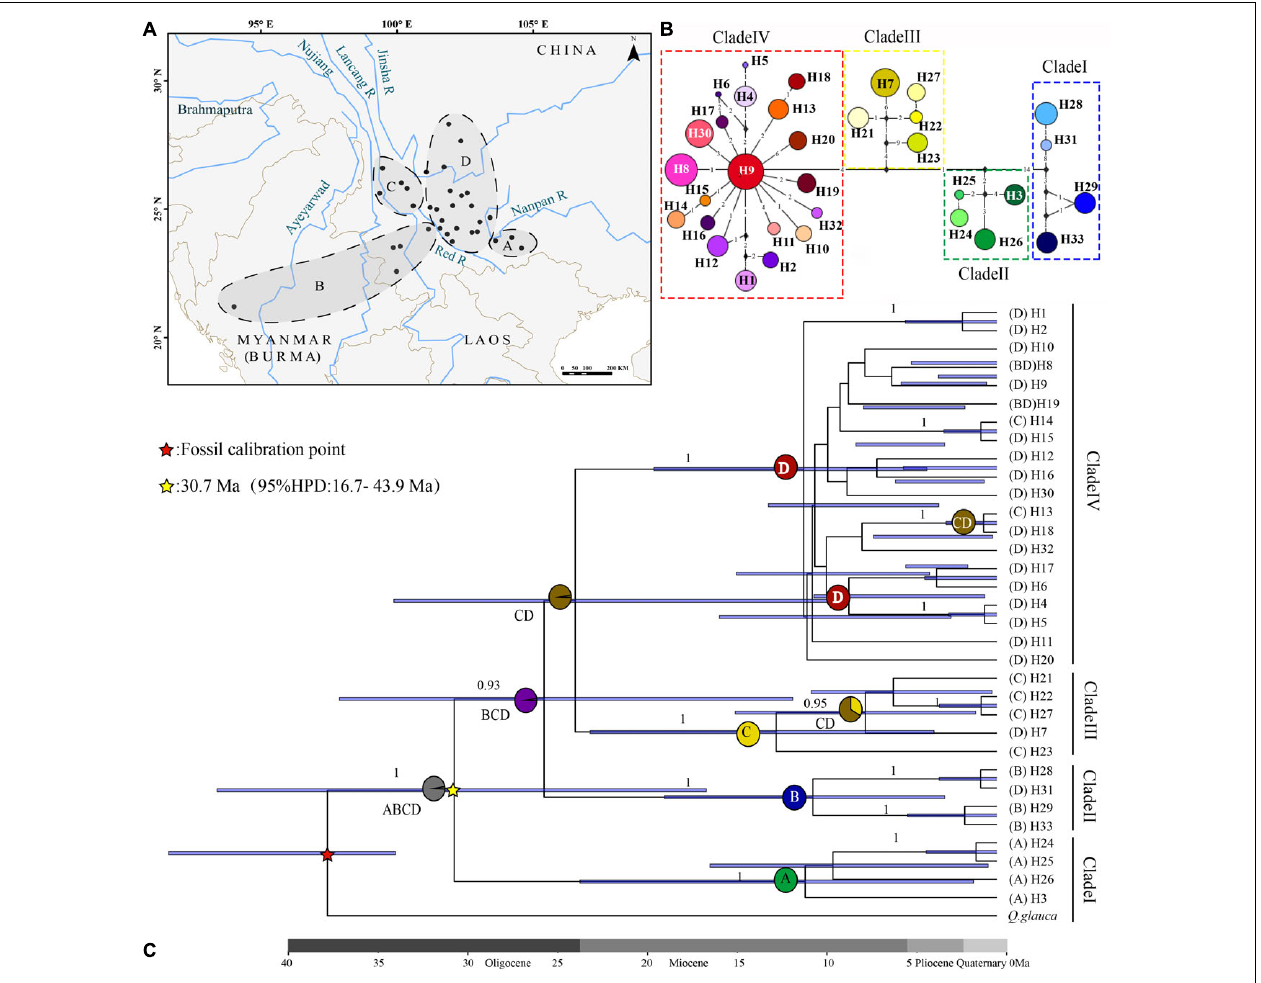
FIGURE 2 | Phylogenetic analysis and ancestral distribution area reconstruction of the Quercus franchetii complex. (A) Ancestral distribution area of the Q. franchetii complex. A, Nanpan River region (NPR); B, southwestern Red River (RR); C, Hengduan Mountains (HDM); D, Yunnan–Guizhou Plateau (YGP). (B) Haplotypes of the cp DNA network of the Quercus franchetii complex. The colors in the pie charts represent different cp DNA haplotypes. Numbers on the branches indicate the number of substitutions. Black diamonds indicate unsampled or extinct ancestral haplotypes. (C) BEAST-derived chronogram of the Q. franchetii complex. The blue bar length represents the 95% HPD of the species divergence time, and circles at nodes represent the distribution range. Values below branches represent the posterior